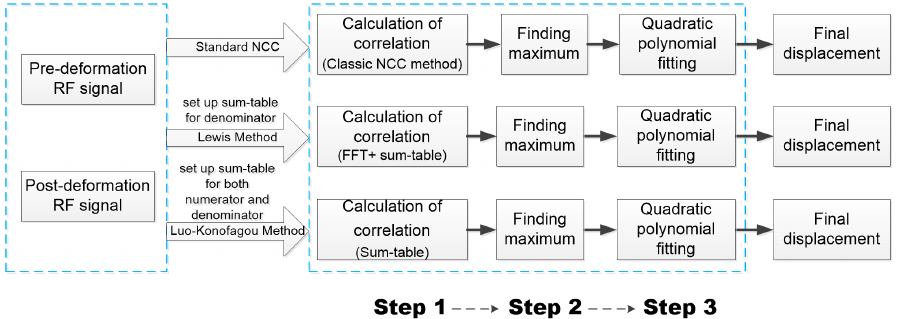
Figure 1. An illustrative diagram show how the calculation of NCC values with and without sum-tables are integrated into ultrasound-based motion tracking. RF signal stands for radiofrequency ultrasound echo